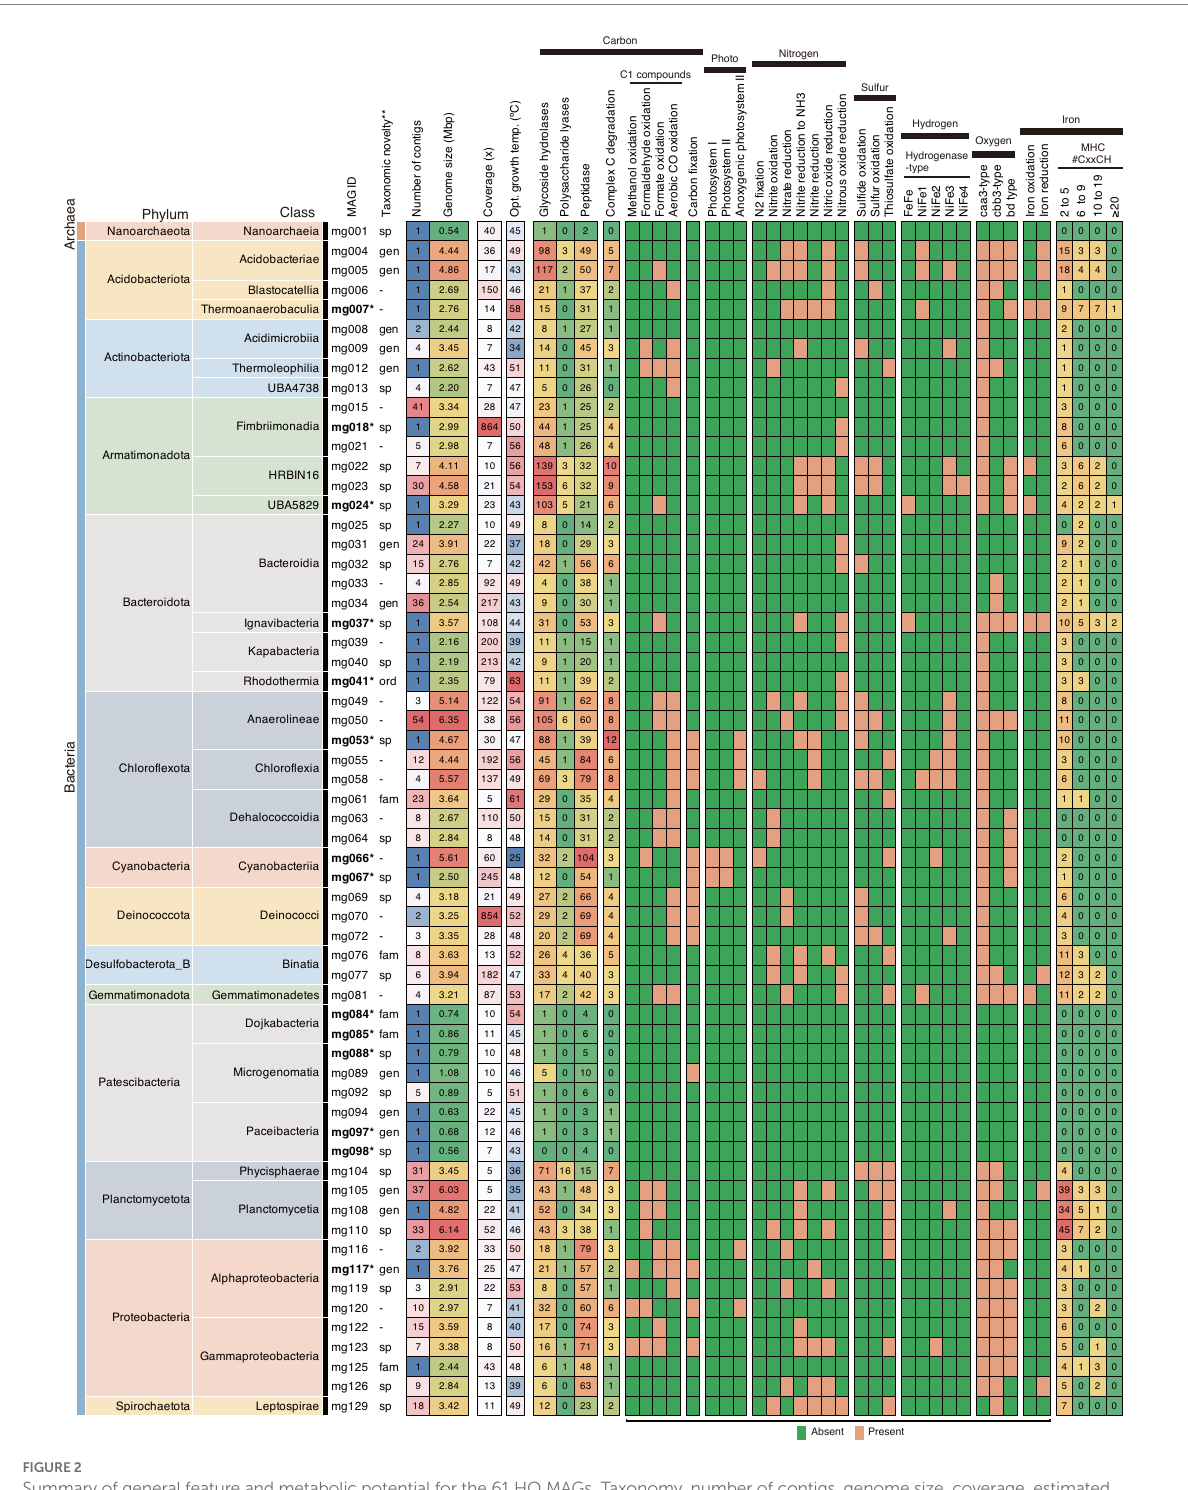
members represented by the MAGs are potentially involved in carbon fixation. If this is the case, the energy sources for carbon